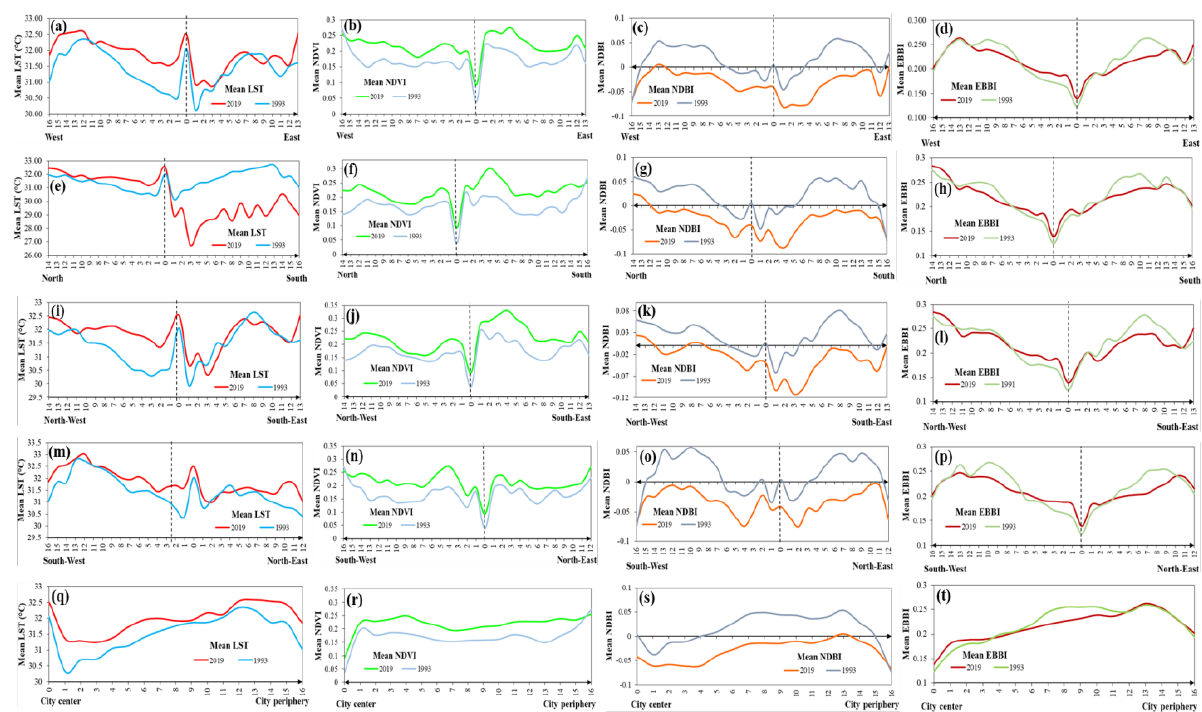
Figure 4. Spatial dynamics of LST and Land Indices: (a - d) Pattern of LST, NDVI, NDBI and EBBI in 1993 and 2019 in West to East direction respectively; (e - h) Pattern of LST, NDVI, NDBI and EBBI in 1993 and 2019 in North to South direction respectively; (i - l) Pattern of LST, NDVI, NDBI and EBBI in 1993 and 2019 in North-West to South-East direction respectively; (m - p) Pattern of LST, NDVI, NDBI and EBBI in 1993 and 2019 in South-West to North-East direction respectively; (q - t) Pattern of LST, NDVI, NDBI and EBBI in 1993 and 2019 on over all analysis from City centre to City periphery respectively